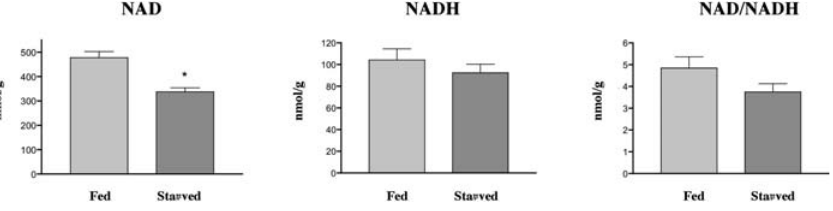
Figure 8. NAD and NADH Levels in Fed and Starved Mice Measurements were made in pancreases of seven fed and seven starved wild-type mice, and levels are expressed as nmol per gram of tissue. The decrease in NAD in starved mice is significant with p , 0.0005, while the NADH levels in fed versus starved are not significantly different. DOI: